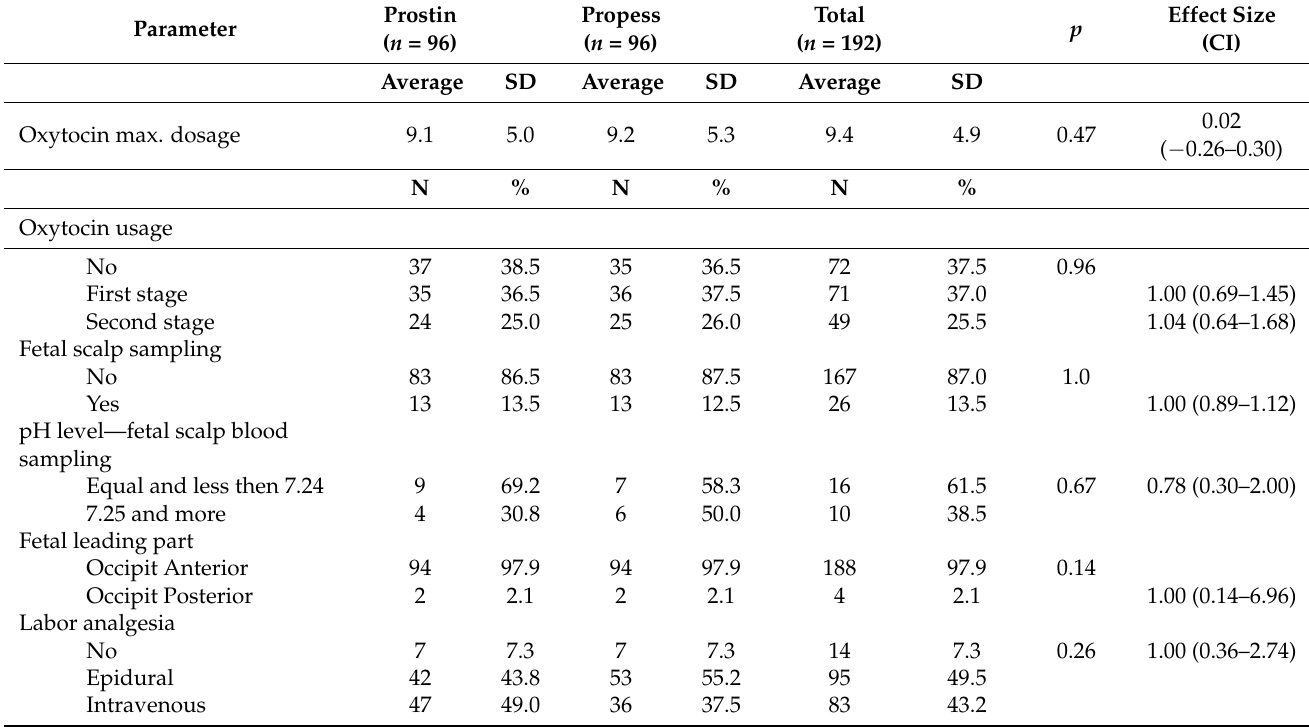
Table 3. Delivery data of the study population according to the study groups. SD—standard deviation, N—number of cases, %—percentage of the group, CI—confidence